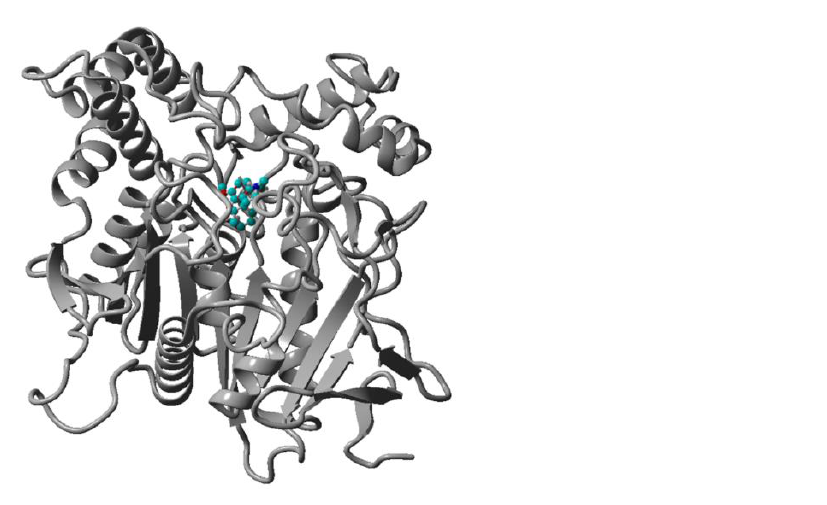
Figure 1. X-ray structure of the complex galantamine (GAL)- rh AChE (pdb code: 4ey6). Protein is given in gray ribbon, GAL—in ball-and-stick colored by element.